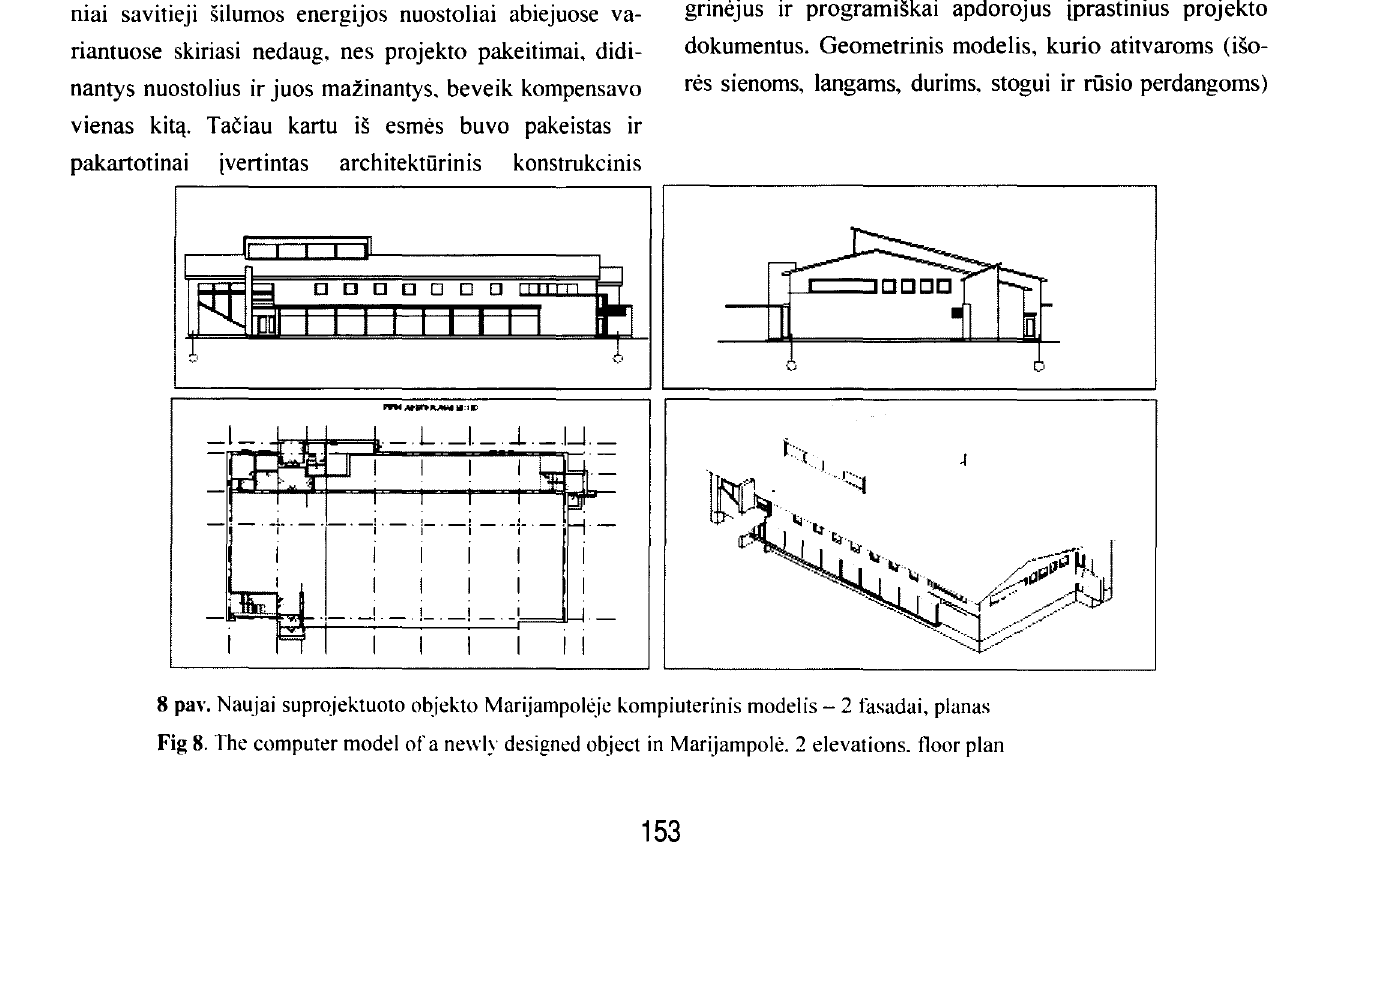
Fig 8. The computer model of a newly designed object in Marijampole. 2 elevations. floor